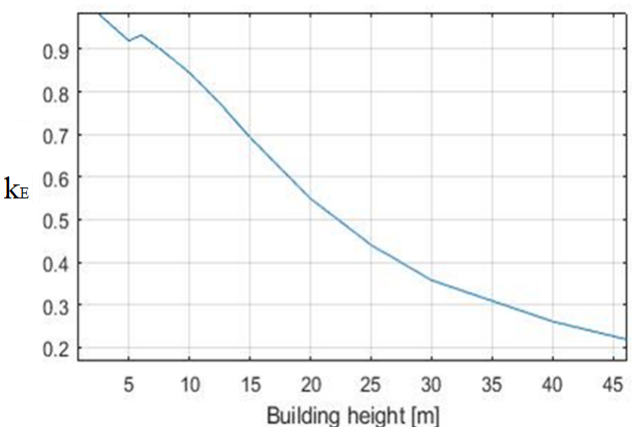
Figure 4. Ratio between the maximum value of the electric field with and without the building. (B) H = 5 m, and d varies from 5 to 200 m.